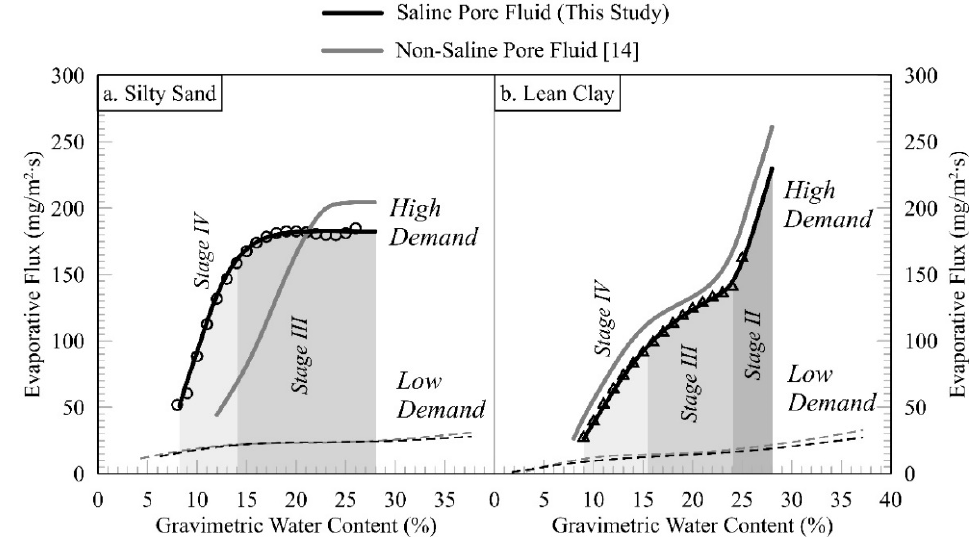
Figure 5. Evaporative flux under high demand for ( a ) silty sand and ( b ) lean clay.